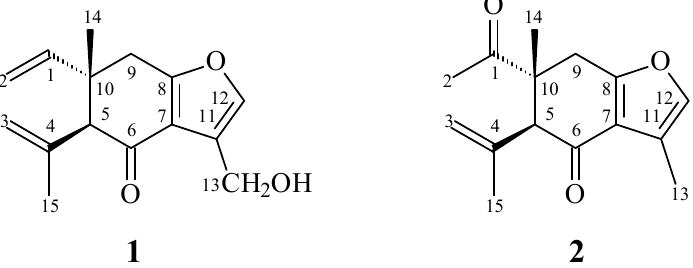
Figure 1. The chemical structures of new compounds 1 and 2 isolated from C. zedoaria .